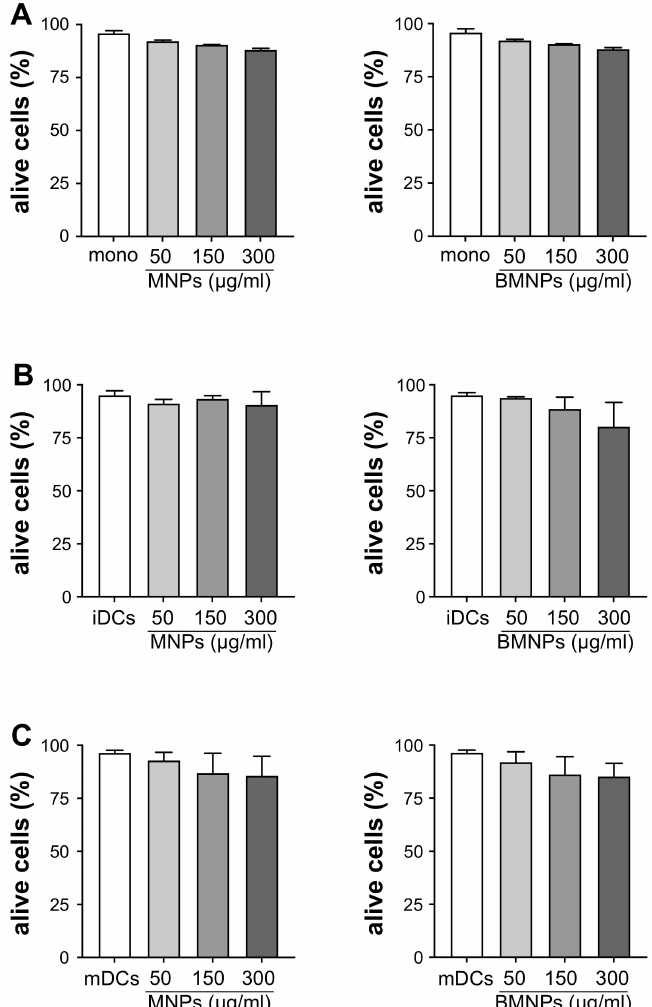
Figure 6. Effects of MNPs and BMNPs on the viability of human monocytes and DCs. Monocytes (mono) ( A ), immature DCs (iDCs) ( B ), and mature DCs (mDCs) ( C ) were challenged with 50, 150 or 300 µ g/mL MNPs or BMNPs for 24 h and cell viability has been assessed by VYBRANT/SYTOX staining by flow cytometry. The results are expressed as the mean value of alive cells frequency + SEM of four independent